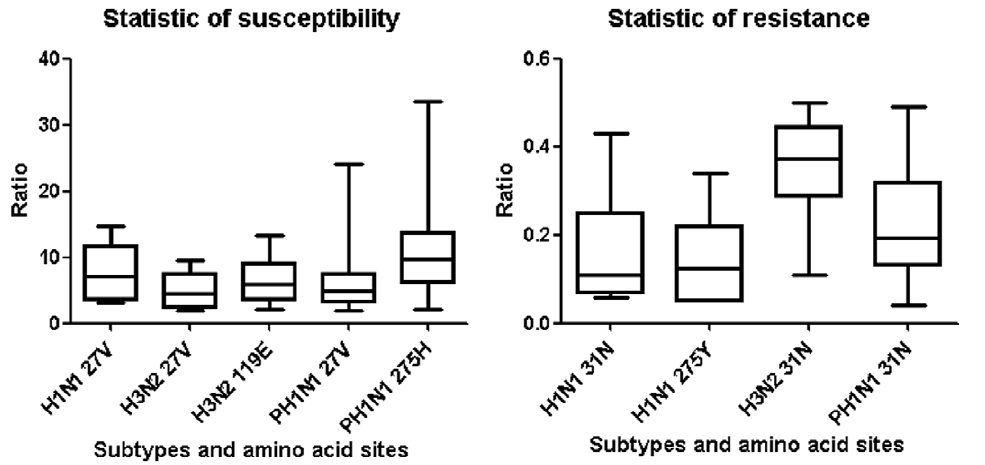
Figure 4. The ratio statistic results of resistance and susceptibility of the clinical throat swap specimens. The ratio of the arithmetic mean of all the wild probes to that of all the mutant probes for the definite subtypes was determined and the statistic results of 281 positive clinical throat swab samples were separately shown in two column graphs by the ratio range of resistance and susceptibility. The statistics showed that the ratios of wild-type sites were greater than 2 and these of mutant-type sites were less than 0.5.